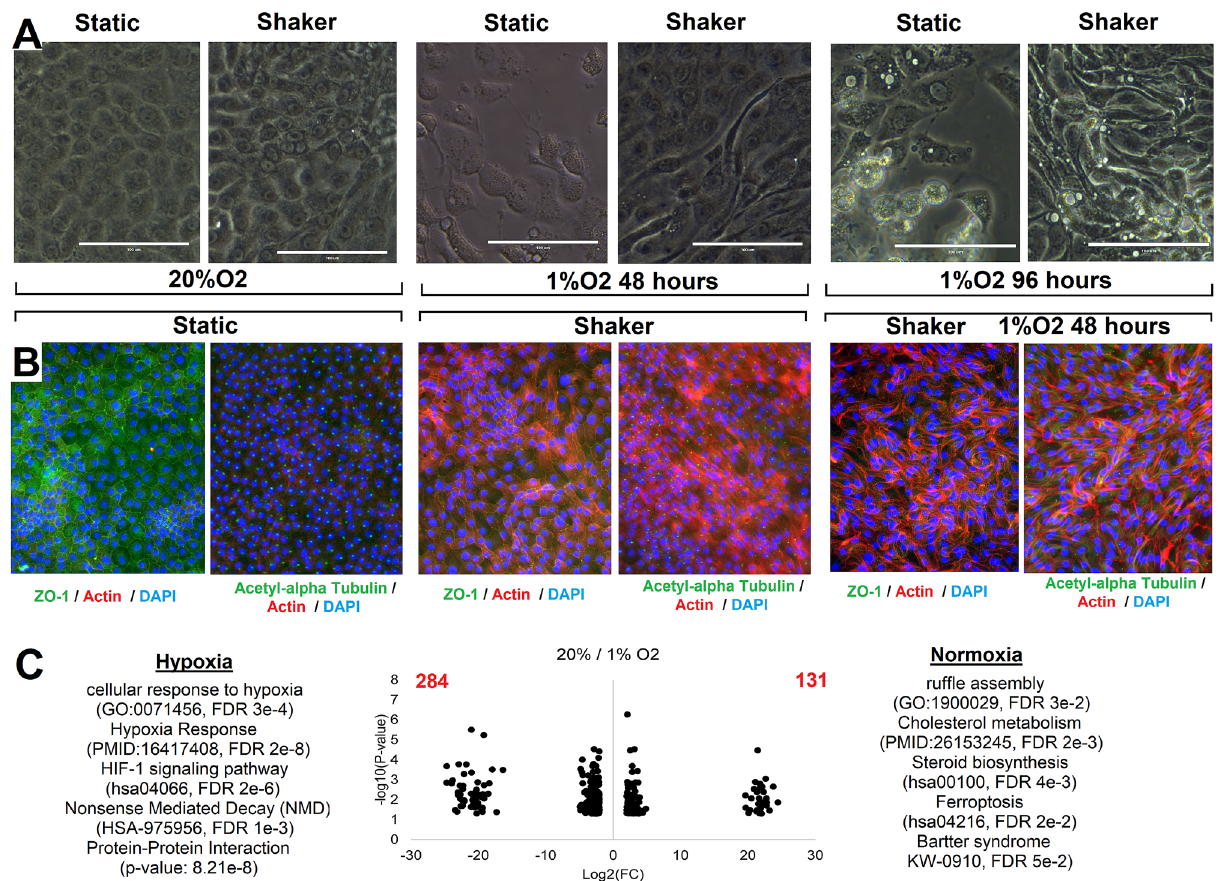
Figure 4. Development of a renal proximal tubule cell culture system using RPTEC-TERT1 cells. ( A ) Light microscope images of RPTEC TERT1 cells under static or shaker conditions in different oxygen concentrations. Note the drawn out structure seen when cells are under hypoxic and shaking conditions. ( B ) Immunofluorescence of different markers in different conditions (ZO1 or aetyl-alpha tubulin in green, Actin in red, nuclei in blue). Actin strands increase and become oriented perpendicular to the fluid flow when under normoxia and constant shaking. Shaking and hypoxia, however, disrupts the cilia and actin strands begin to surround the cells. ( C ) Volcano plot of RNAseq for the log2 of normoxic vs hypoxic conditions, with significant pathways shown on the right and left of the